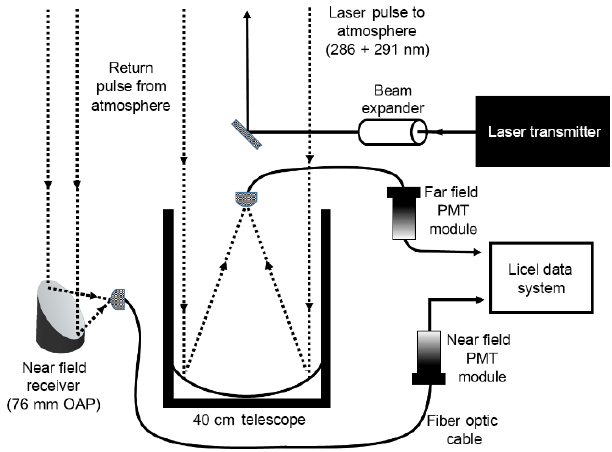
Figure 1. System setup with OAP mirror receiver adjacent to the larger far-field receiver.